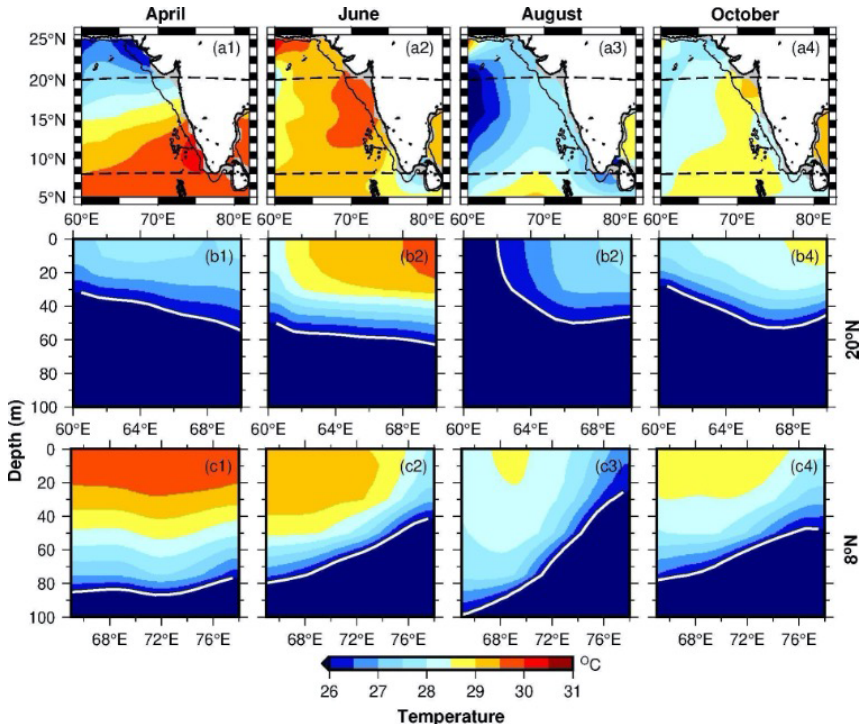
Figure 14. Monthly climatology of temperature from April to October. The data are from the North Indian Ocean Atlas (Chatterjee et al., 2012). (a1–a4) Sea surface temperature from the eastern Arabian Sea. The black contour represents the 1000m water-column depth, and the horizontal dashed lines are 20 and 8 ◦ N. (b1–b4) Vertical section of temperature at 20 ◦ N. (c1–c4) Vertical section of temperature at 8 ◦ N. The white contour is 26 ◦ C. The figure highlights how the upwelling evolves from the pre-monsoon to post-monsoon season along the west coast of India. The upwelling sets in earlier in the south and progresses slowly towards the north. The upward tilt of the isopycnals, though weak, is evident at 20 ◦ N towards the end of the summer monsoon.